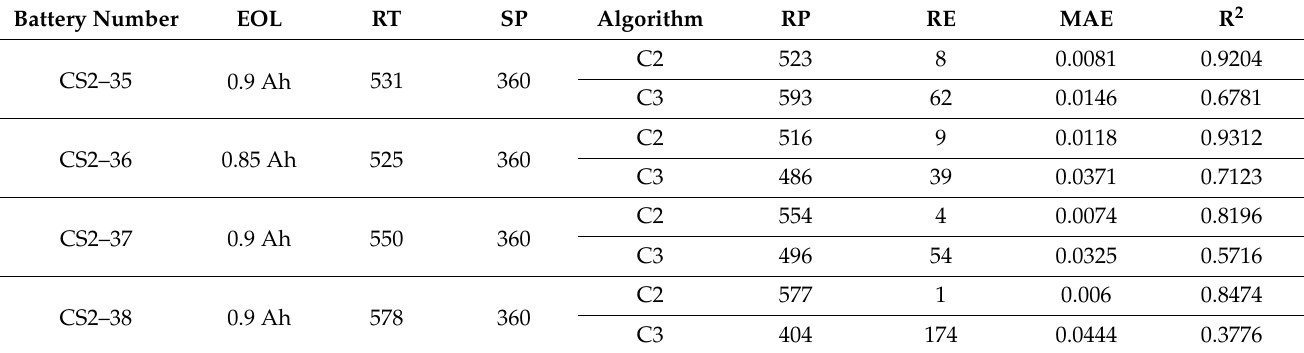
Table 5. Short–term prediction experimental error